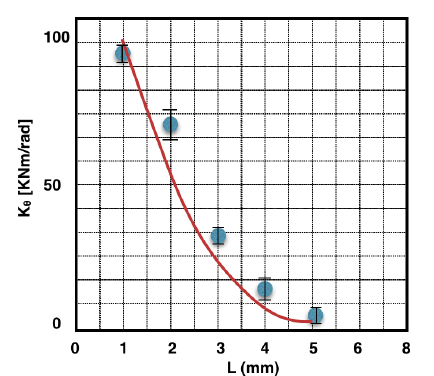
Figure 8. Stiffness of the proposed actuator as a result of different setting for the length of the cantilever L .